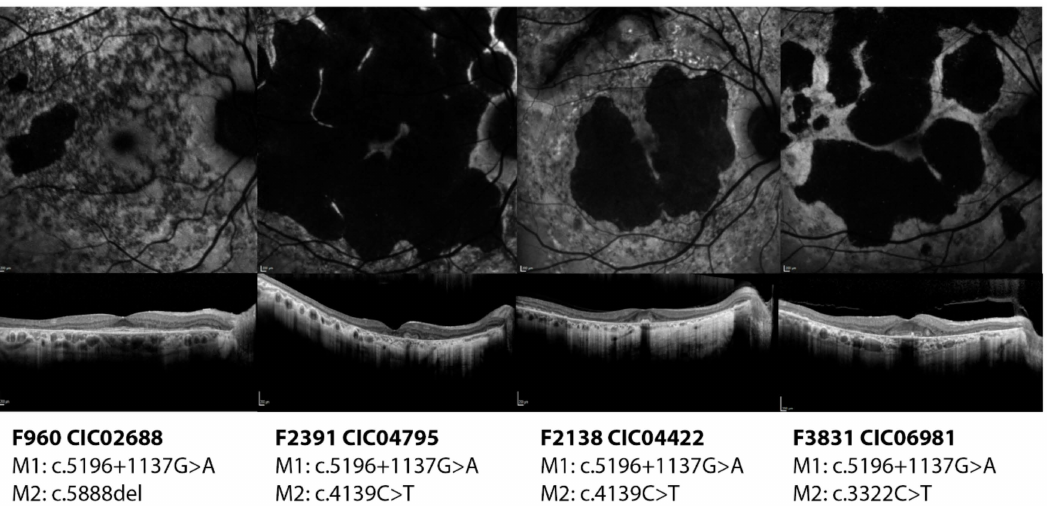
Figure 3. Short wavelength autofluorescence images and optical coherence tomography foveal scan of the right eyes of four patients carrying the deep-intronic variant c.5196 + 1137G > A. All four patients show a di ff use disease with macular atrophy. However, they all show foveal preservation which ensure them a relatively good residual visual